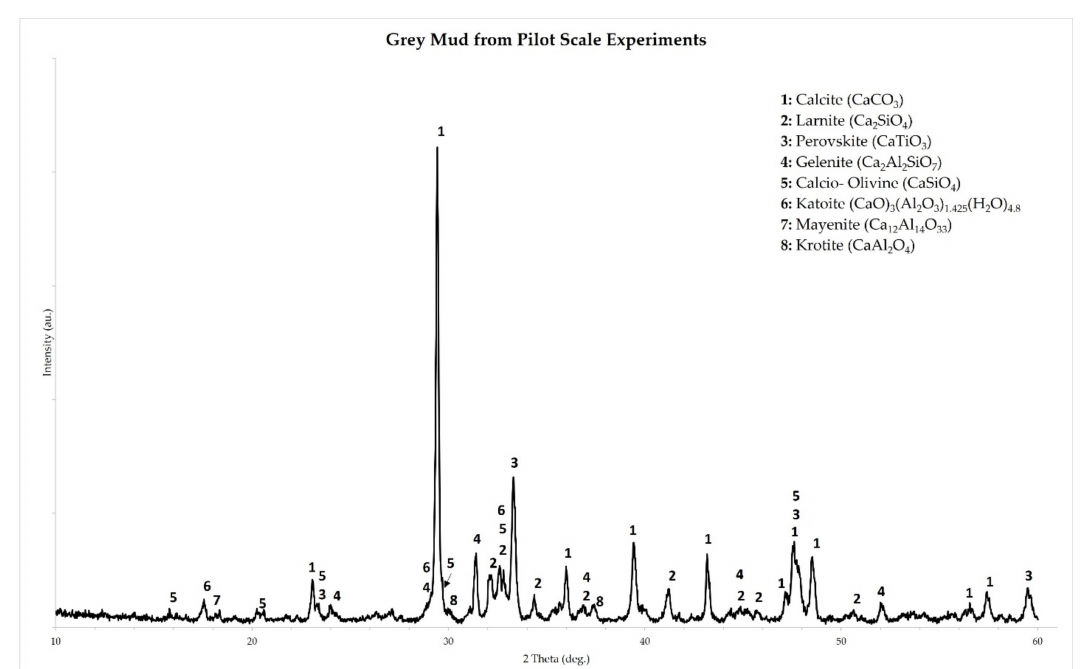
Figure 9. Powder X-ray Diffractogram and phase identification of the grey mud produced at the pilot scale leaching experiments of this